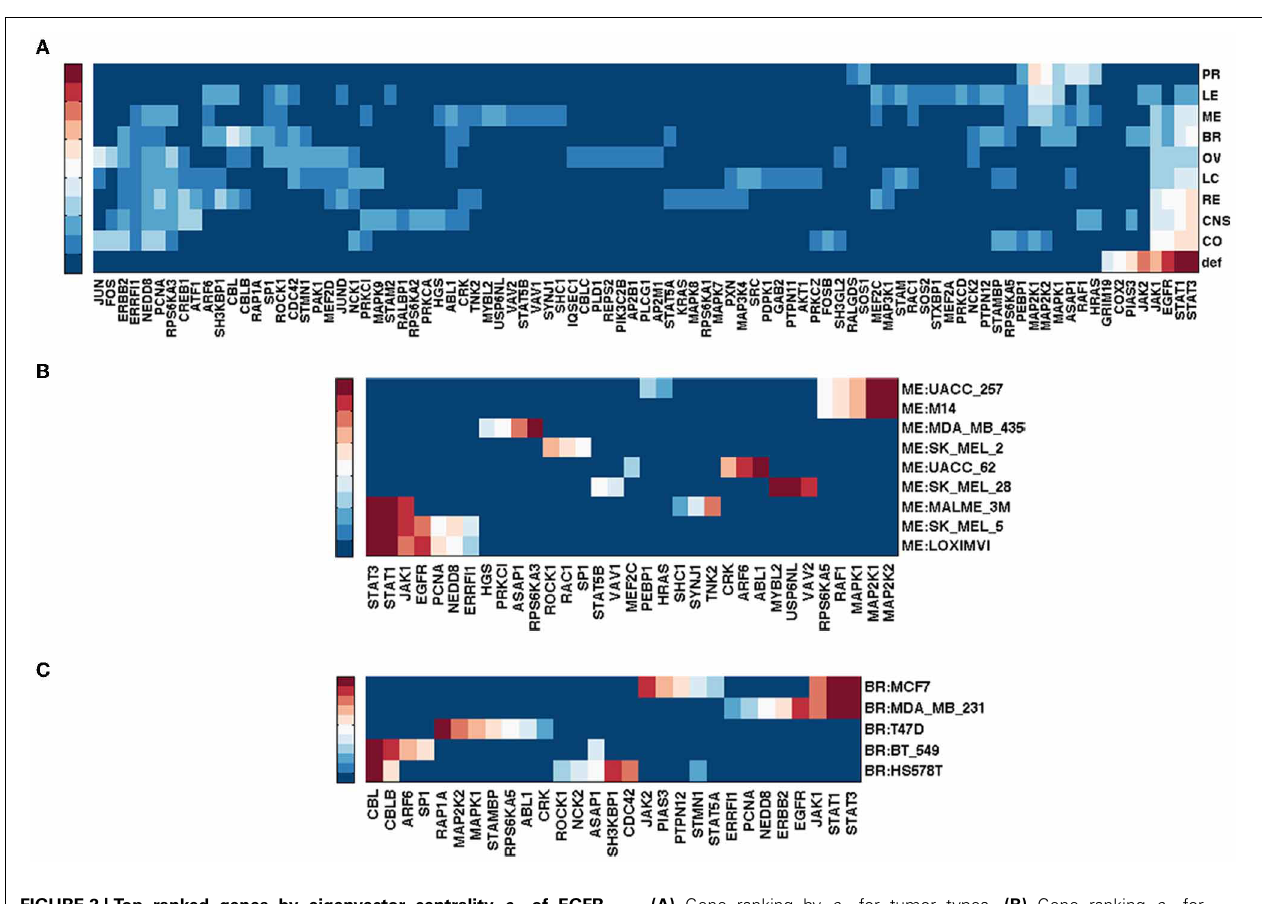
FIGURE 2 | Top ranked genes by eigenvector centrality c e of EGFR pathway conditioned on NCI60 cell line gene expression. Ranks range from 1 (dark red) to 10 (blue), and > 10 (the darkest blue).